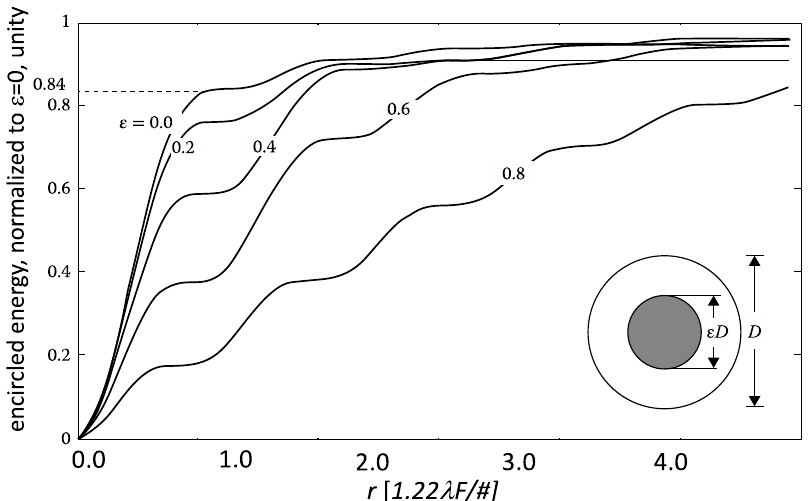
Figure 1. The normalized integrated, encircled energy as a function of radius r of the enclosing circle for an ideal, diffraction-limited optical system with a circular aperture. The obscuration ratio ε is a parameter (ratio of radii), varying from 0 (no obscuration) to 0.8 in increments of 0.2. The degree of compactness of the central spot may be recognized from the average slope of these curves for radial values less than 1. About 84% of the energy is enclosed within the first dark ring of a diffraction-limited optical system without the central obscuration. All the curves also flatten to zero slope for radial distances that correspond to the zero-rings, due to the absence of radiation there.